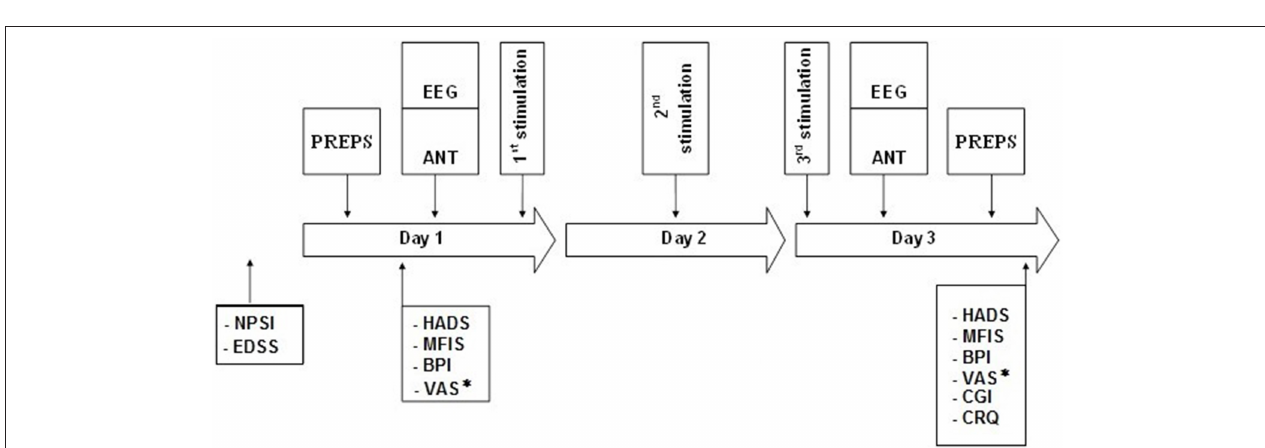
FIGURE 2 | An example of artifact rejection in a single EEG record.